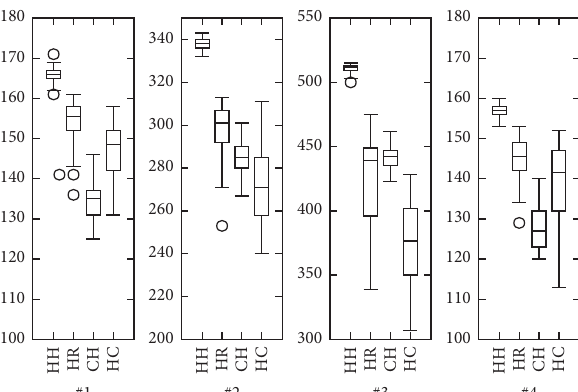
Figure 5: Boxplots of lengths of schedules (minimum, lower quartile, median, upper quartile, maximum, and outliers) returned by the LS algorithms for the benchmark given in [7, 8] with cov �